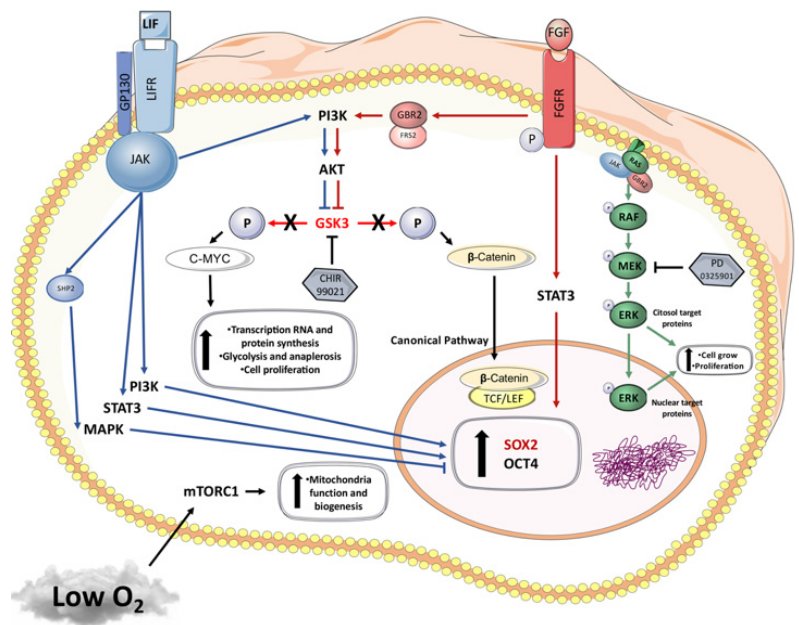
Figure 4. Graphical hypothesis of molecular pathways involved on the cell signaling process during the reprogramming process using different inhibitors of differentiation and low oxygen tension, based on our results, as well as literature data